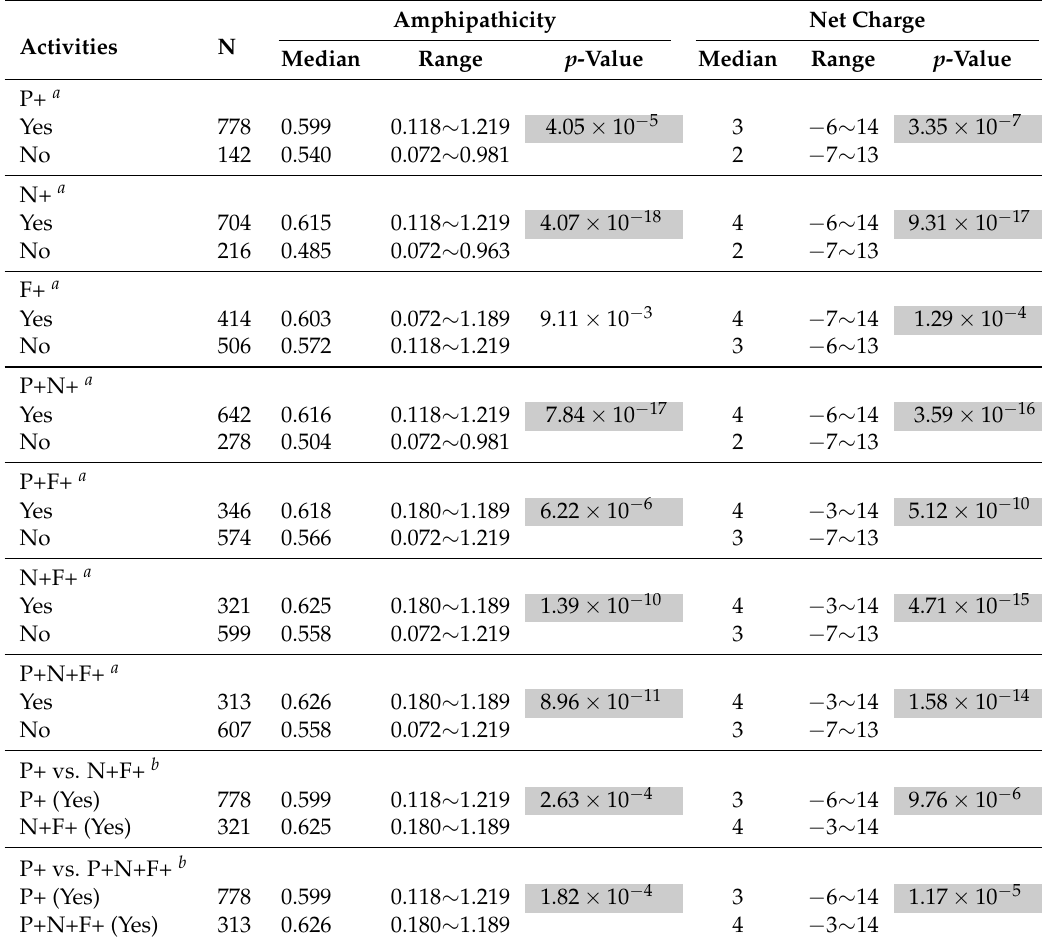
Table 1. Significant antimicrobial activities of antimicrobial peptides (AMPs) in relation to amphipathicity and net